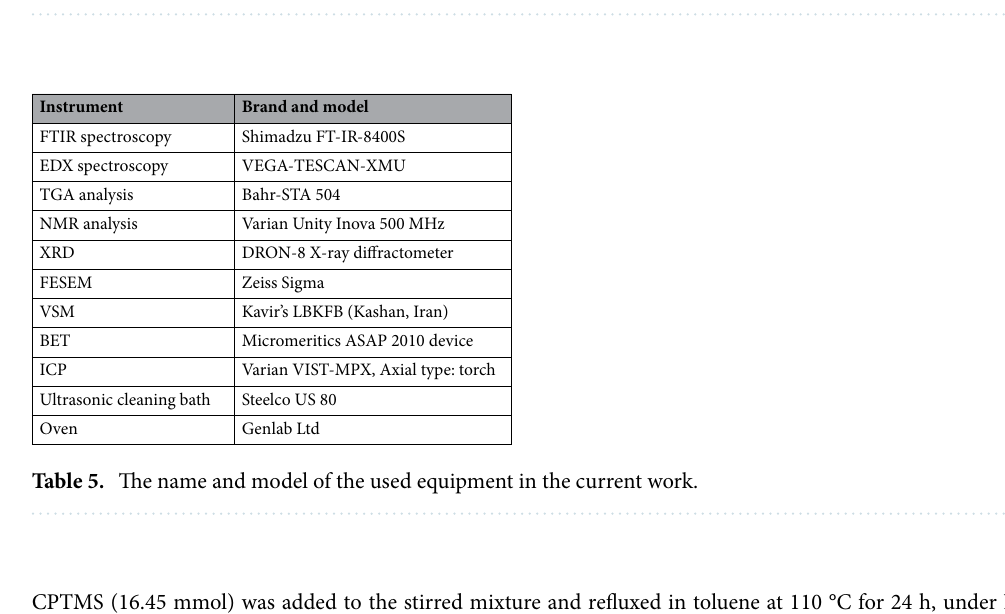
Table 4. The name, brand and purity of the used chemical materials in the current work.